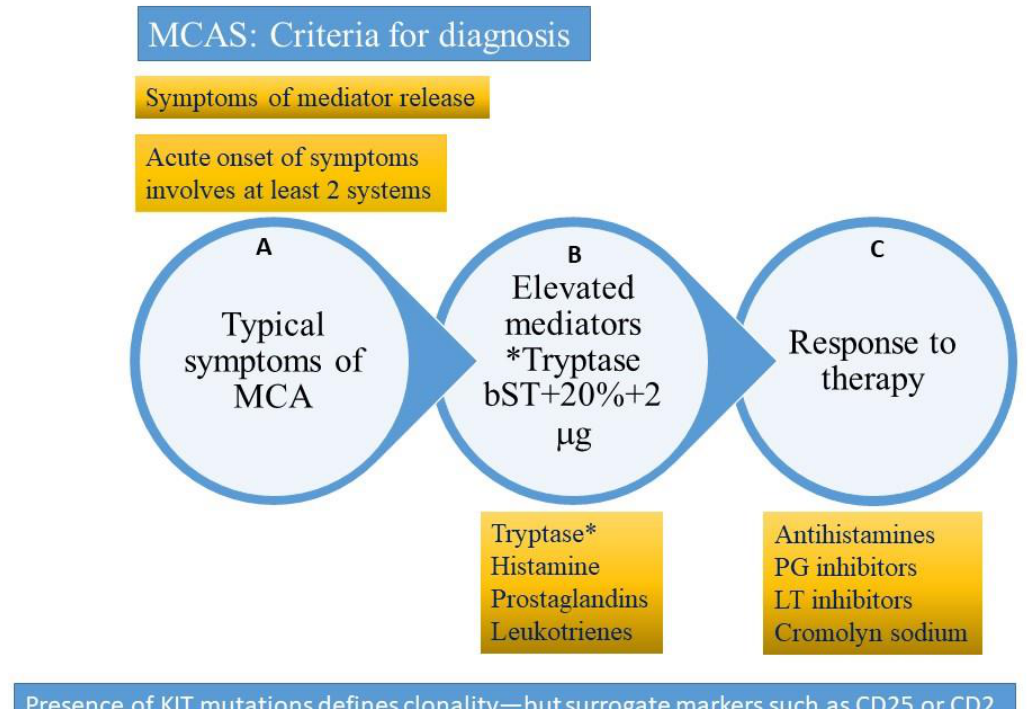
Figure 4. Criteria for diagnosis of mast cell activating syndrome (please refer to text for description). A = clinical criterion, B = laboratory criterion, C = treatment criterion. All three criteria need to be satisfied to confirm a diagnosis of mast cell activation syndrome (MCAS). The presence of clonality ( KIT D816V mutation or surface expression of CD2 or CD25 clonal markers) would suggest a diagnosis of clonal (primary) mast cell activating syndrome also referred to as the monoclonal mast cell activation syndrome (MMAS). * Tryptase (total tryptase) is usually used as a surrogate marker for mast cell activation. PG = prostaglandin, LT-leukotriene, MCA = mast cell activation. bST = basal serum tryptase.